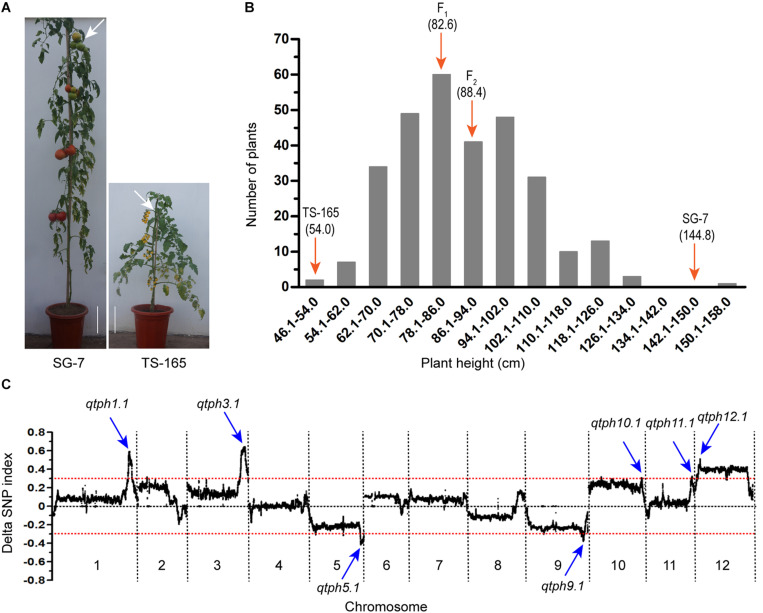
Identification of tomato plant height QTLs. (A) Plant height phenotype of tomato lines SG-7 and TS-165. Scale bars indicate 10 cm and white arrows point to the fourth truss. (B) Plant height distribution in the F2 population derived from the cross between SG-7 and TS-165. (C) Average values of the ΔSNP-index calculated by a sliding window from QTL-seq analysis.